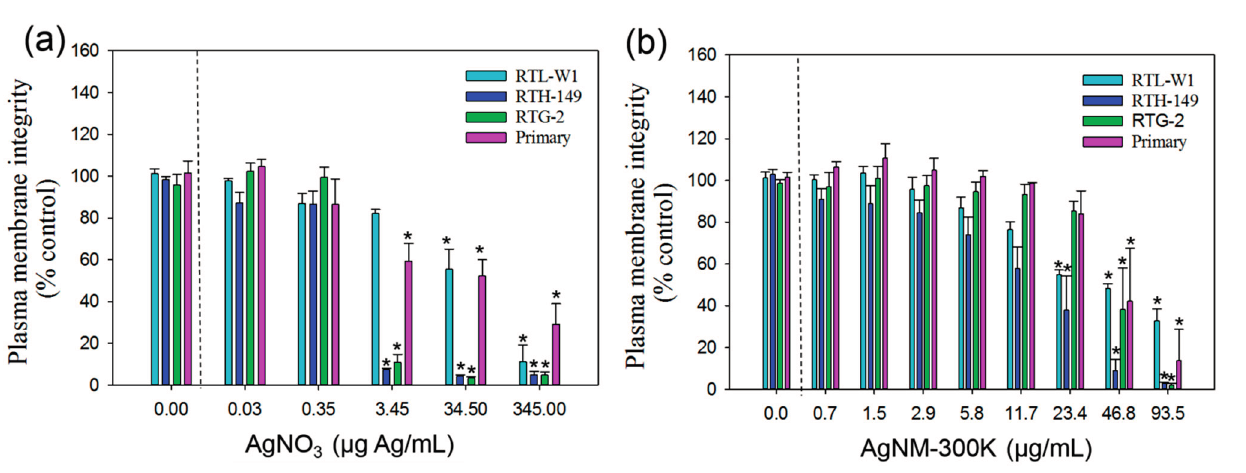
Figure 2. Cytotoxicity of AgNO 3 and AgNPs NM-300K according to CFDA-AM assay; ( a ) Cytotoxicity measured using the CFDA-AM assay and plasma membrane integrity as endpoint of toxicity in liver cell lines (RTL-W1 and RTH-149), a gonadal cell line (RTG-2) and primary hepatocytes from rainbow trout following 24 h exposure to AgNO 3 ; ( b ) silver nanomaterial NM-300K. Cells exposed to concentration 0 received the maximal concentration of the dispersant and served as control. Values represent the mean ± standard error of the mean (SEM) (n = 3); * denotes statistically significant differences from control ( p <